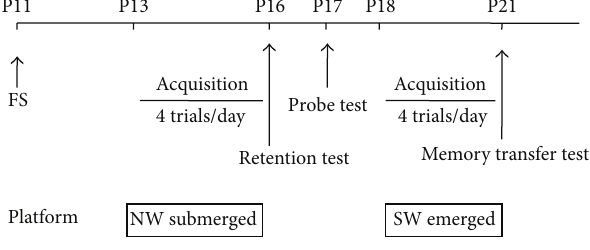
Figure 1: Treatment and behavioural testing protocol for treated group 1 (Tr1). The same procedure was applied for treated 2 and 3 groups. P11: postnatal day 11; FS: febrile seizure; NW: northwest; SW: